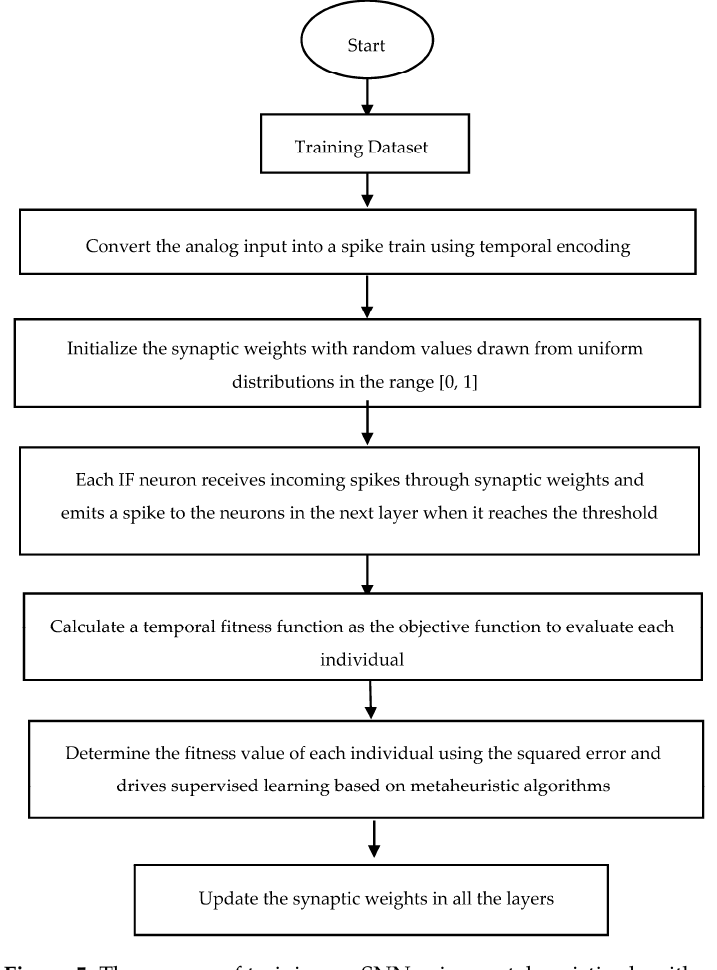
Figure 5. The process of training an SNN using metaheuristic algorithms.